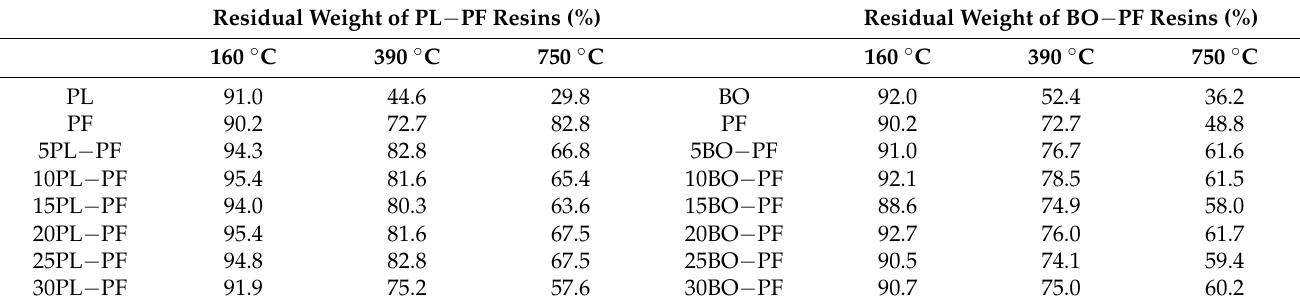
Table 3. Residual weight of PL, BO, PF, PL − PF resins and BO − PF